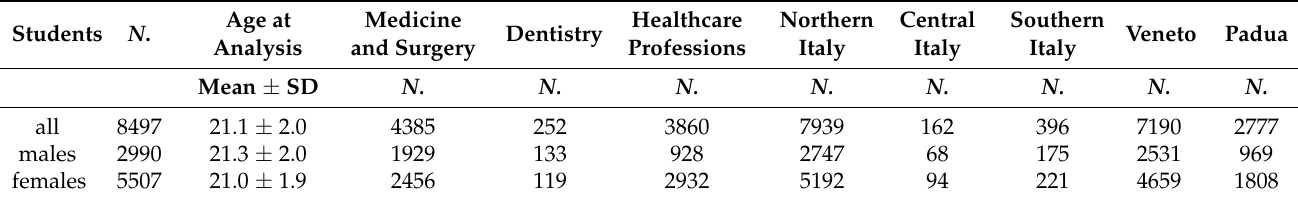
Table 1. Characteristics of enrolled students according to graduate course and geographical origin. Students N